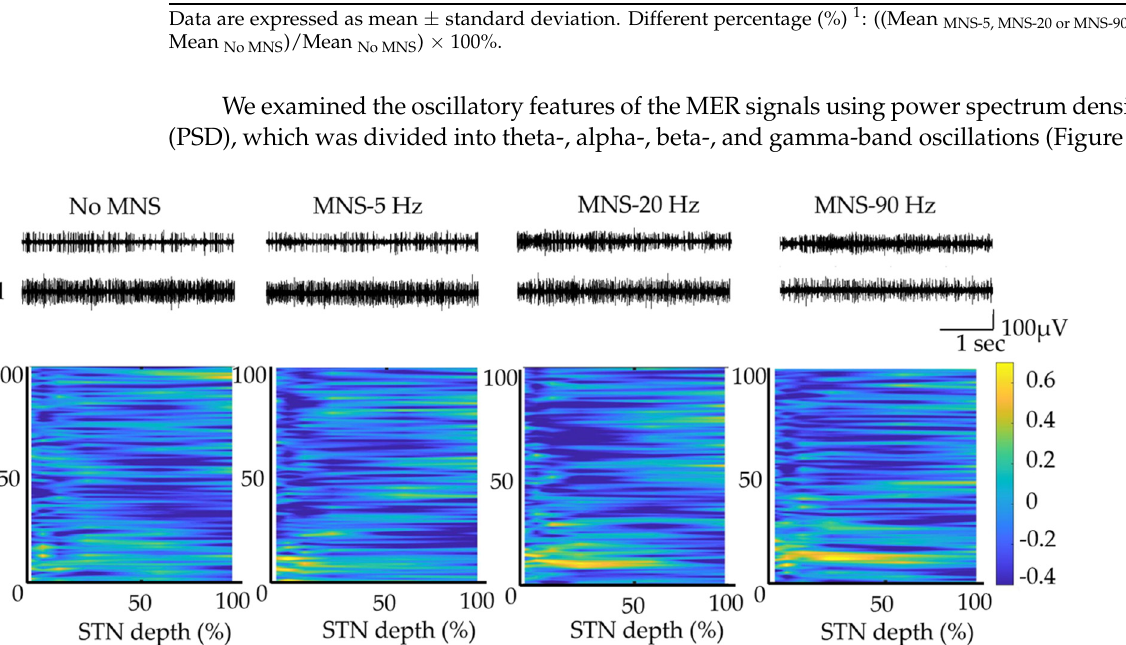
Figure 2. The analysis of power spectral density (PSD) in the dorsal and ventral subthalamic nucleus (STN) under no MNS and various frequencies of MNS. ( A ) Two representative microelectrodes recorded data from the dorsal and ventral STN under no MNS and various frequencies of MNS. ( B )